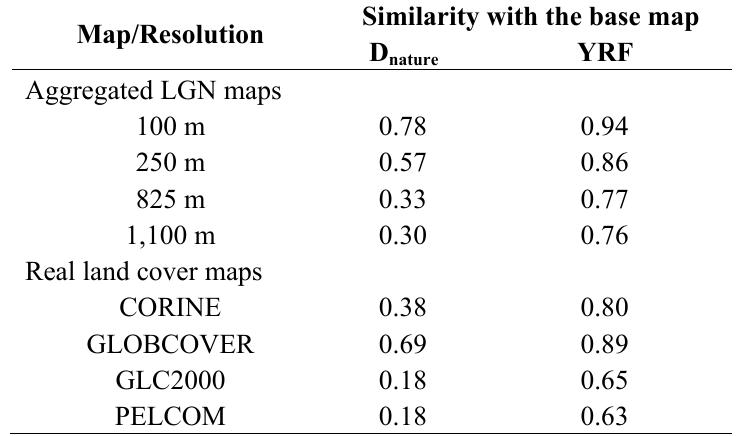
Table 4. Fuzzy numerical similarity statistics for comparison with the base